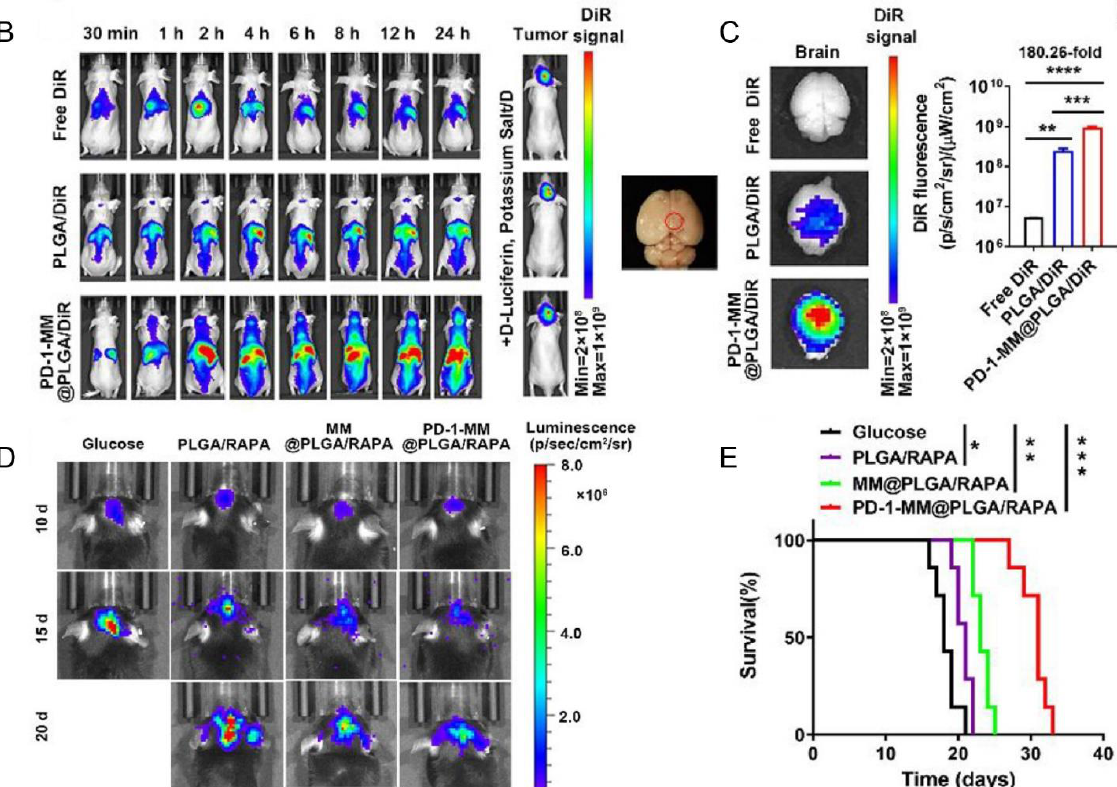
Figure 10. ( A ) Schematic illustration of the synthesis and proposed mechanism of PD-1-engineered macrophage membrane-coated nanoparticles. ( B ) In vivo bioluminescent fluorescence images of PD-1-MM@PLGA/DiR NPs in mice bearing orthotopic C6-luc glioblastoma. ( C ) Ex vivo the accumulation of PD-1-MM@PLGA/DiR NPs in the brain. ( D ) Whole-body imaging of the bioluminescent fluorescence and ( E ) survival curve of C6 glioma mice after PD-1-MM@PLGA/RAPA NP treatment. * p < 0.05; ** p < 0.01; *** p < 0.001; **** p < 0.0001. PD-1, programmed cell death-1; PD-L1, programmed cell death-ligand 1; MM, macrophage membrane; PLGA, poly(lactic-co-glycolic acid); RAPA, rapamycin; CTL, cytotoxic T-lymphocyte. Reprinted with permission from Ref. [132], Copyright © 2022, American Chemical Society.